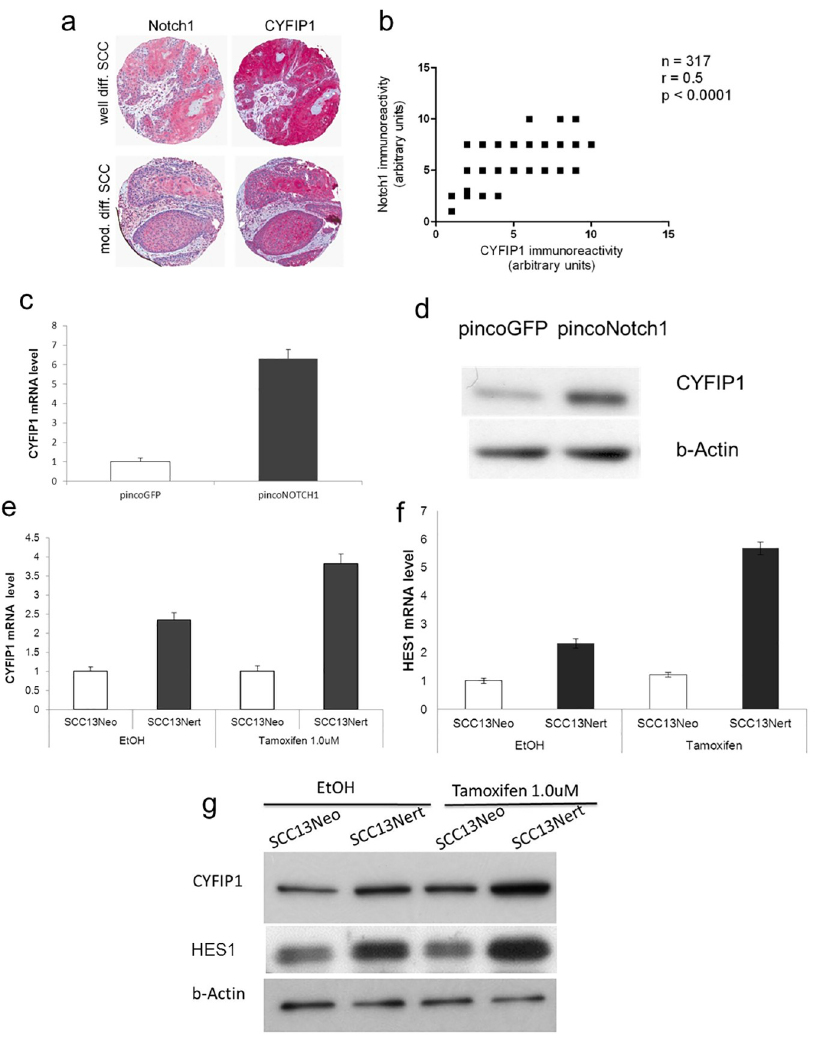
Fig 2. CYFIP1 is induced during keratinocyte differentiation through a Notch-dependent mechanism. (a) 4 um adjacent sections of SCC tissue microarray were separatelystainedfor CYFIP1 and NOTCH1 (n = 286). Immunohistochemicalanalysisof their expressionin humanSCC showedsimilar immunoreactivity patterns for both proteins.The expression was concomitantly increased in the suprabasalepidermislayers. (b) Statistical analysisof the immunoreactivity showedsignificantcorrelation of expressionbetweenNOTCH1 and CYFIP1 with the r = 0.5; p < 0.0001.(c) SCC13 cells wereinfected with a recombinant retrovirus expressing constitutively active Notch1 together with GFP (pincoNotch1), or with a virus overexpressing GFP (pincoGFP) alonefollowed,72 h later, by mRNA and (d) proteinexpressionanalysis.Similarresults were obtainedin three independent experiments. (e) SCC13cells were stably infectedwith a retroviralvector expressinga flag- taggedactivated Notch1proteinfused to the humanestrogenreceptor(SCC13Nert), or empty vector control (SCC13Neo). Cells were subsequently treated with Tamoxifenat 1.0 uM concentration, collectedafter 30hand analyzedfor CYFIP1 and (f) HES1 mRNA and (g) proteinexpression.Tamoxifen mediatedactivationof the Notch1pathwaysignificantly increased the mRNA and proteinlevelsof both CYFIP1 and HES1 whichhas served as control downstream target.